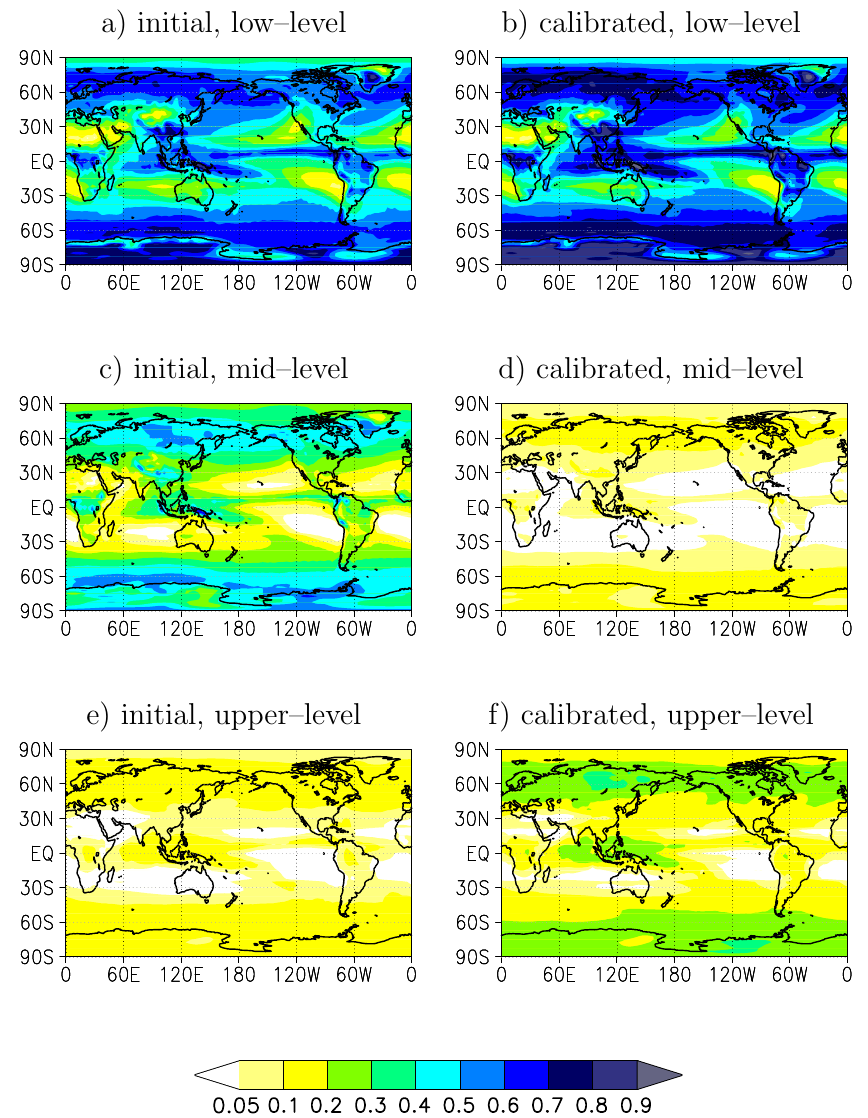
Fig. 5. Annual mean low-level cloud fraction c l ≡ c sl + c co ( a and b ), mid-level cloud fraction c m ≡ c sm ( c and d ), and upper-level cloud fraction c h ≡ c sh ( e and f ) for the model versions with initial ( a , c and e ) and calibrated ( b , d and f ) parameter sets. The units are fractions.